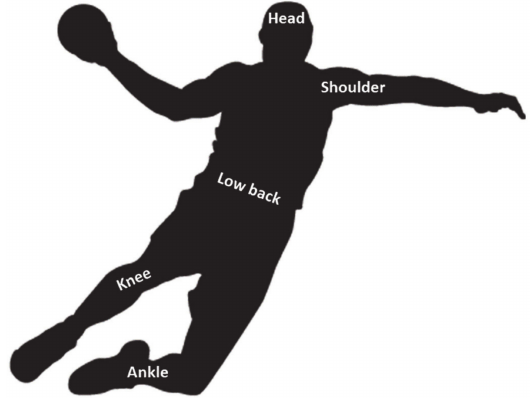
Figure 3. Locations with increased risk of